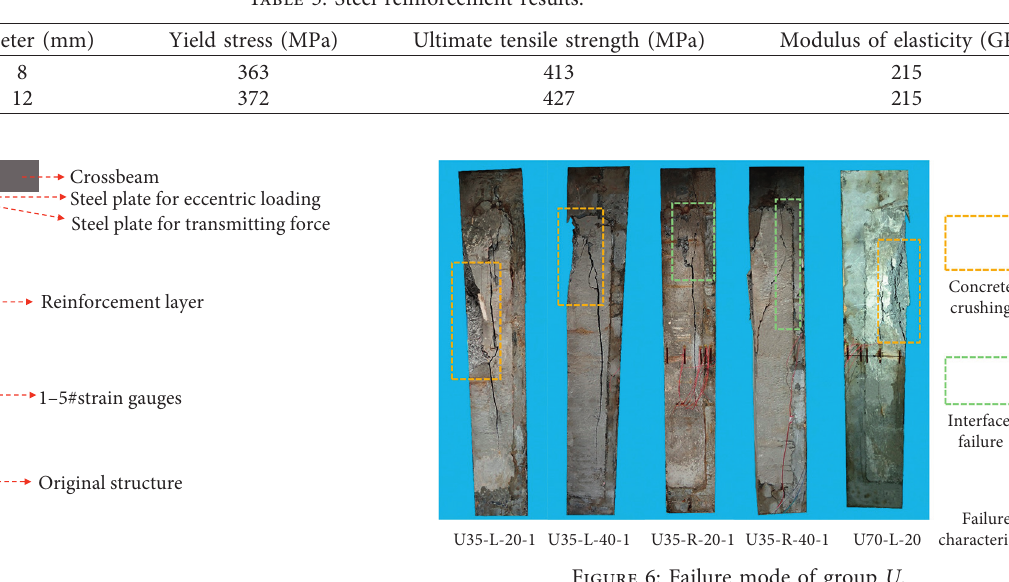
Figure 6: Failure mode of group U